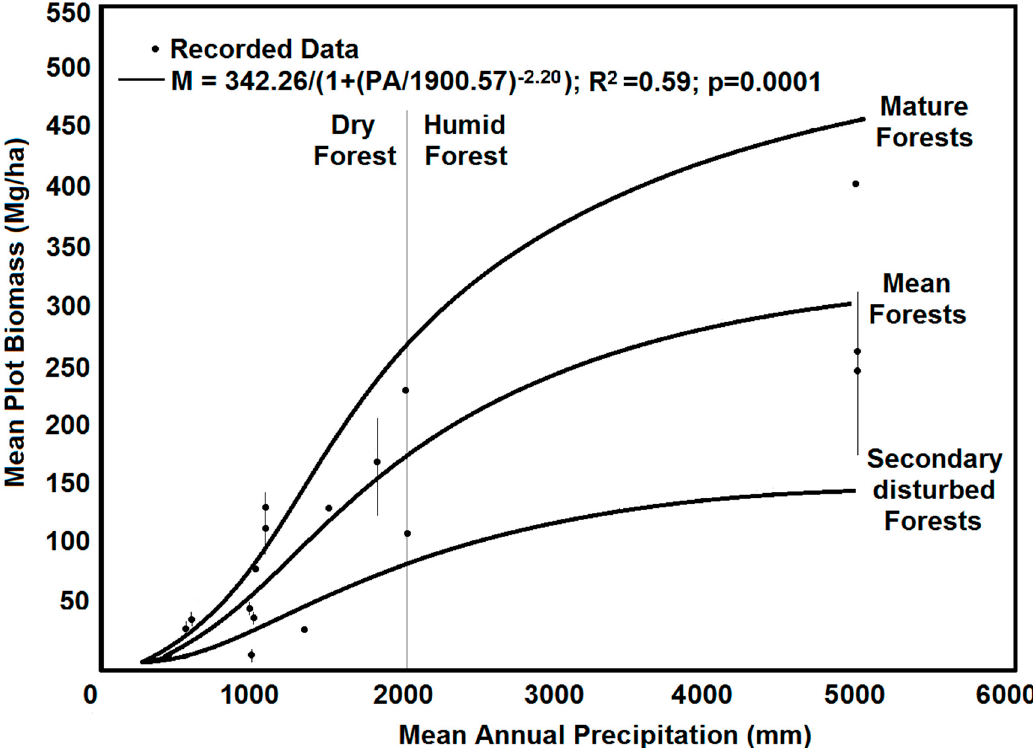
Figure 5. The relationship between mean annual precipitation and forest biomass for primary and secondary forests. The relationship increases and then levels out in the humid forests [67]. The figure is reproduced under CC 4.0 from Navar-Chaidez [67] and includes additional points for Mata Seca, Brazil, and Santa Rosa, Costa Rica collected from Enviro-Net field data.